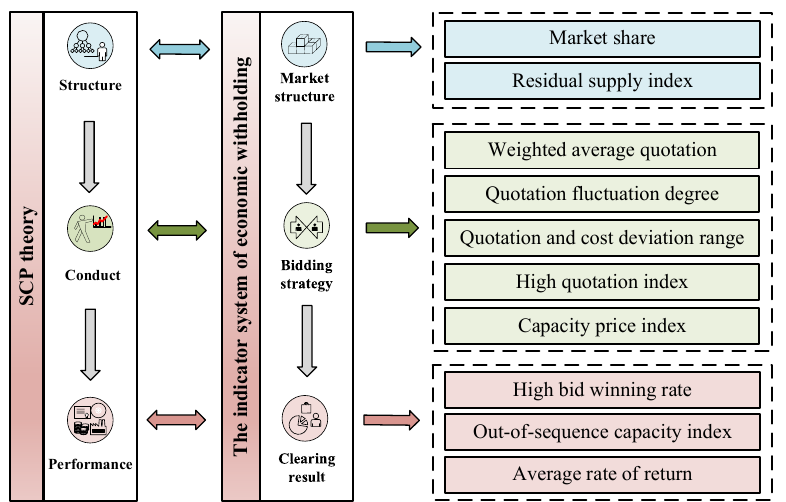
Figure 1. An indicator system for identify economic withholding behavior of the generators.